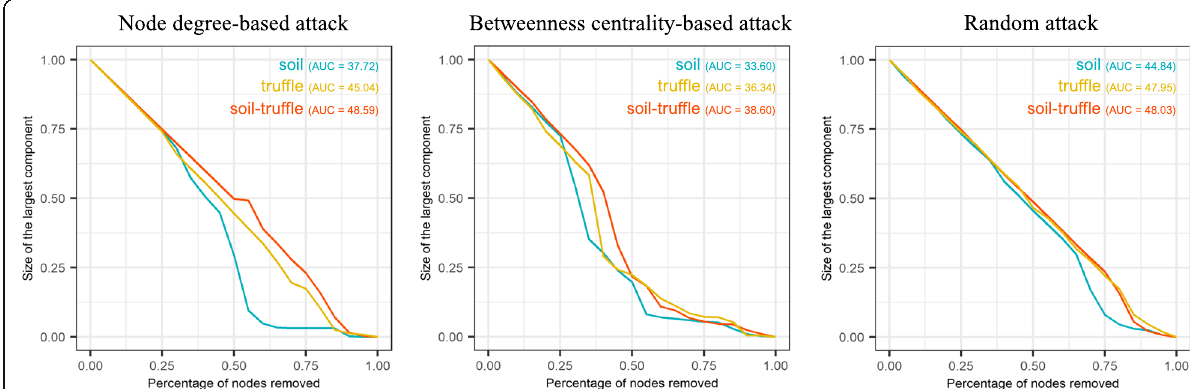
Fig. 7 Attack robustness strategy to measure network resilience. Node removal was performed in agreement with their centrality, considering both node degree ( a ) and betweenness centrality ( b ) or by a random selection ( c ). The robustness was measured as percentage of nodes remaining in the main connected component of the network (clique). Here we plotted the results of this analysis performed on each of the three networks as a line (blue for soil, yellow for truffle, and red for soil-truffle). On the X-axis are reported the percentages of nodes removed, while on the Y-axis the percentage of the nodes remaining in the clique. AUC indicates the area under the curve calculated according to Gini ’ s